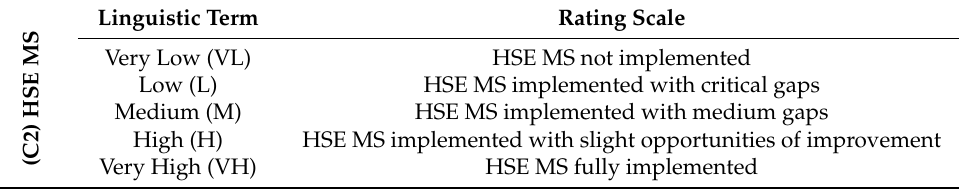
Table 4. Management system (C2) rating